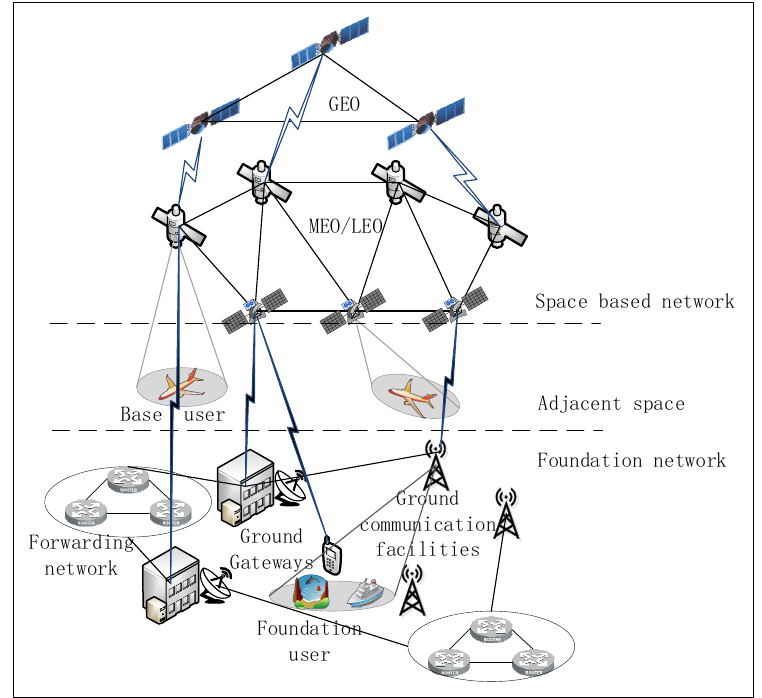
Figure 1. Satellite communication model diagram.